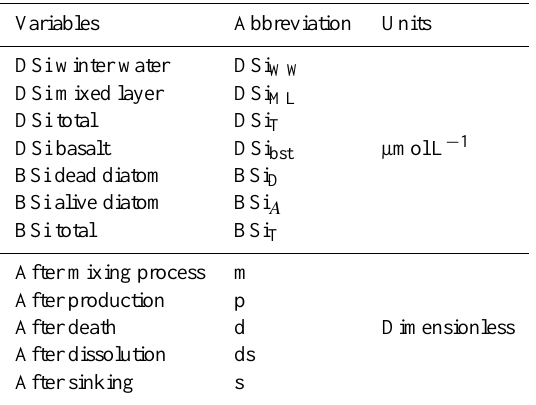
Table 2. Parameter values used in the model. Symbol Parameter Unit Value µ max Maximum growth rate of phytoplankton d − 1 1.5 a K Si Half-saturation constant for Si-limited growth µmolL − 1 3.9 m Mixing coefficient between ML and WW md − 1 H/50 g Mortality rate of phytoplankton d − 1 0.192 b τ BSi dissolution rate d − 1 0.035 c V min Minimal sinking speed md − 1 1 V max Maximal sinking speed md − 1 20 δ 30 Si bst Isotopic composition of DSi released during basalt weathering ‰ − 1.00 + 1.80 d δ 30 Si ww Isotopic composition of DSi from the WW ‰